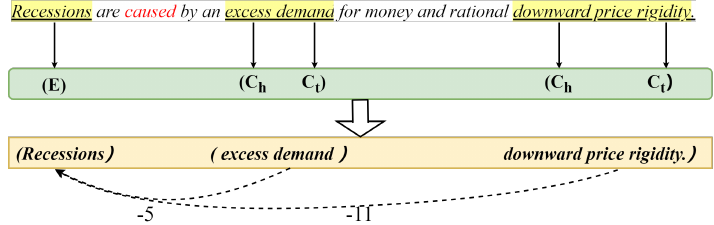
Figure 9. Multi − causal sentence